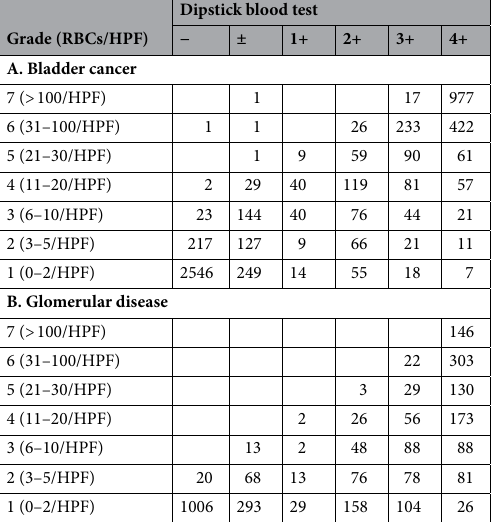
Table 2. The distributions of urine RBC counts measured using the Cobas 6500 urine analyzer at each positive degree of dipstick blood test in patients with bladder cancer (A) and glomerular disease (B). RBCs red blood cells, HPF high power field.